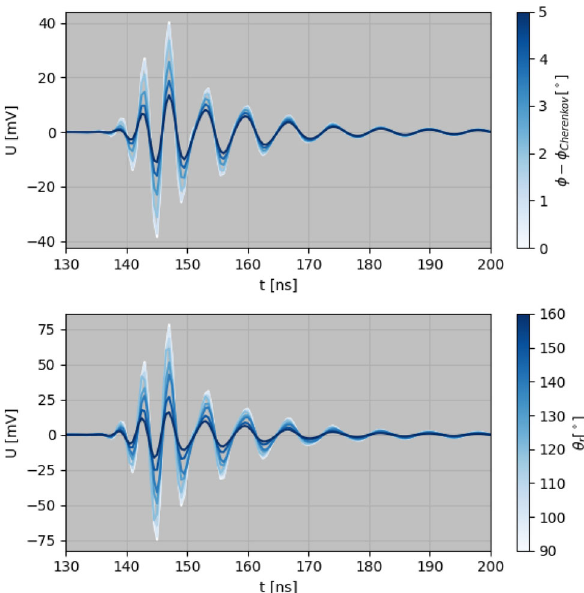
Fig. 4 Examples of waveforms measured by an RNO-G Vpol channel, filtered to the 130 MHz to 300 MHz passband, for different viewing angles (top) and zenith angles of the signal arrival direction (bottom)